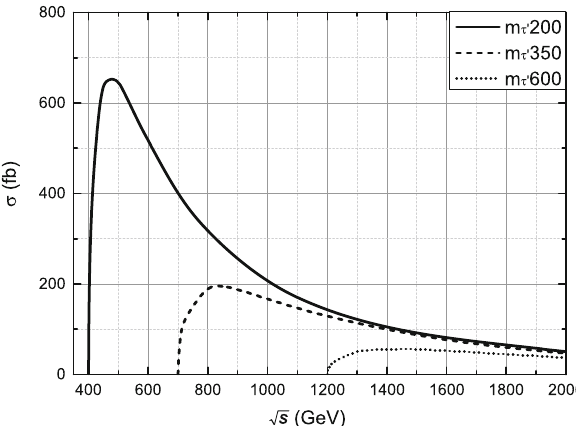
√ s for m τ (cid:2)± =